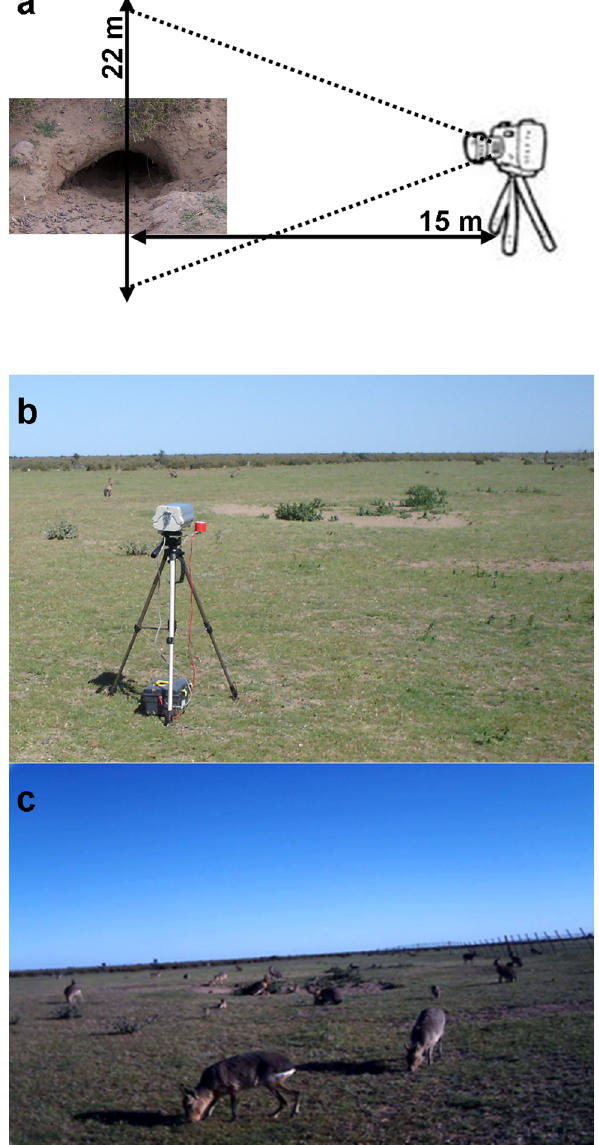
Fig 2. Camera setting. Panel a shows the distance between the camera and warren and the surveyed area given camera ’ s lens aperture. Panel b shows an example of a camera setting in a shrub-grass landscape. Panel c shows a snapshot of a video recorded in a shrub-grass